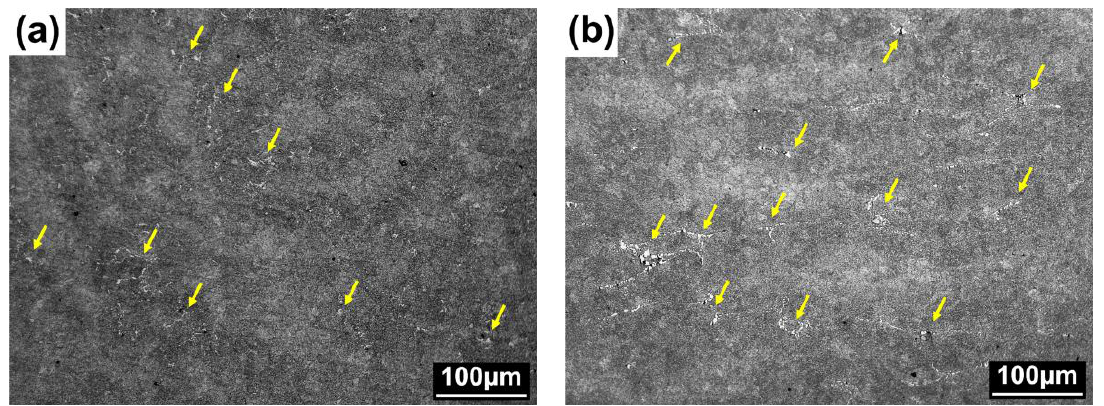
Figure 2. Optical micrographs of the tempered specimens: ( a ) Cr6C9 and ( b ) STD11. The arrows indicate the primary carbide in a bright color.